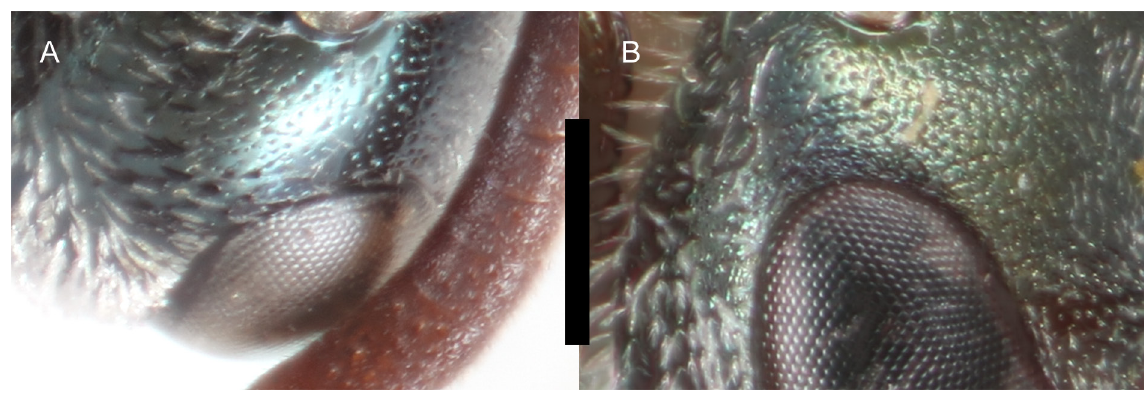
Fig. 106. Ocellocular area. A . Lasioglossum ( D. ) clavicorne sp. nov., ♀, sparsely and distinctly punctate. B . L. ( D. ) clematisellum (Cockerell, 1904), ♀, densely punctate with punctures somewhat obscured by microsculpture. Scale bar: 0.25 mm.